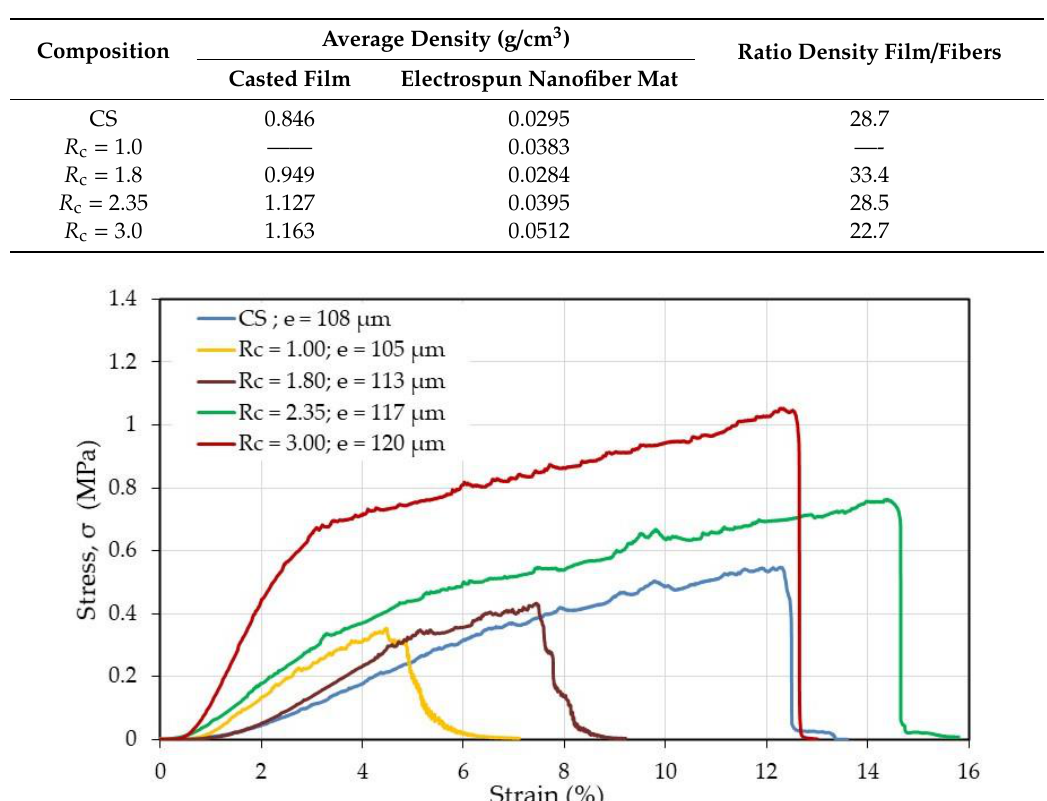
Table 4. Morphological Characteristics of Films and Fibers Tested in Mechanical Experiments. Influence of the Charge ratio, R c .